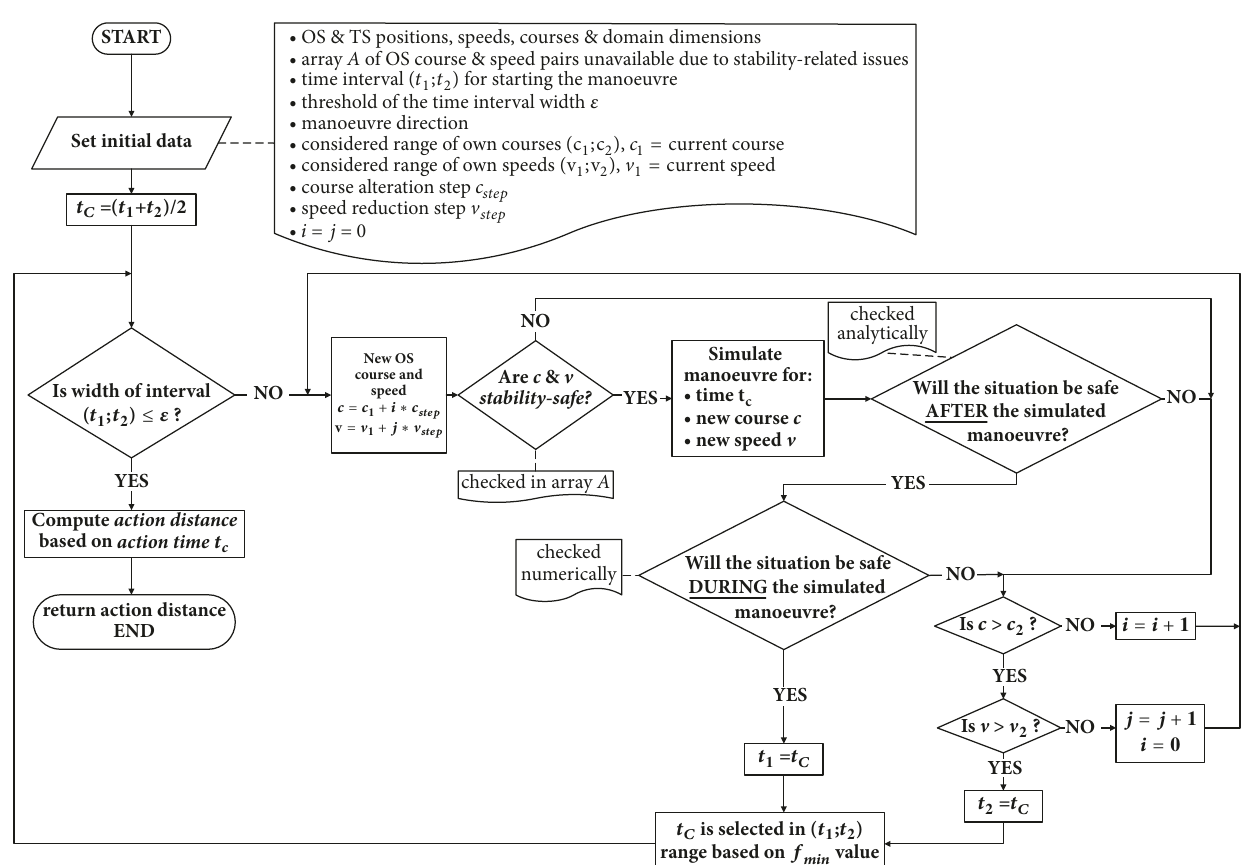
Figure 2: A multistep gradient algorithm returning time, when a manoeuvre should be started in a stand-on situation.